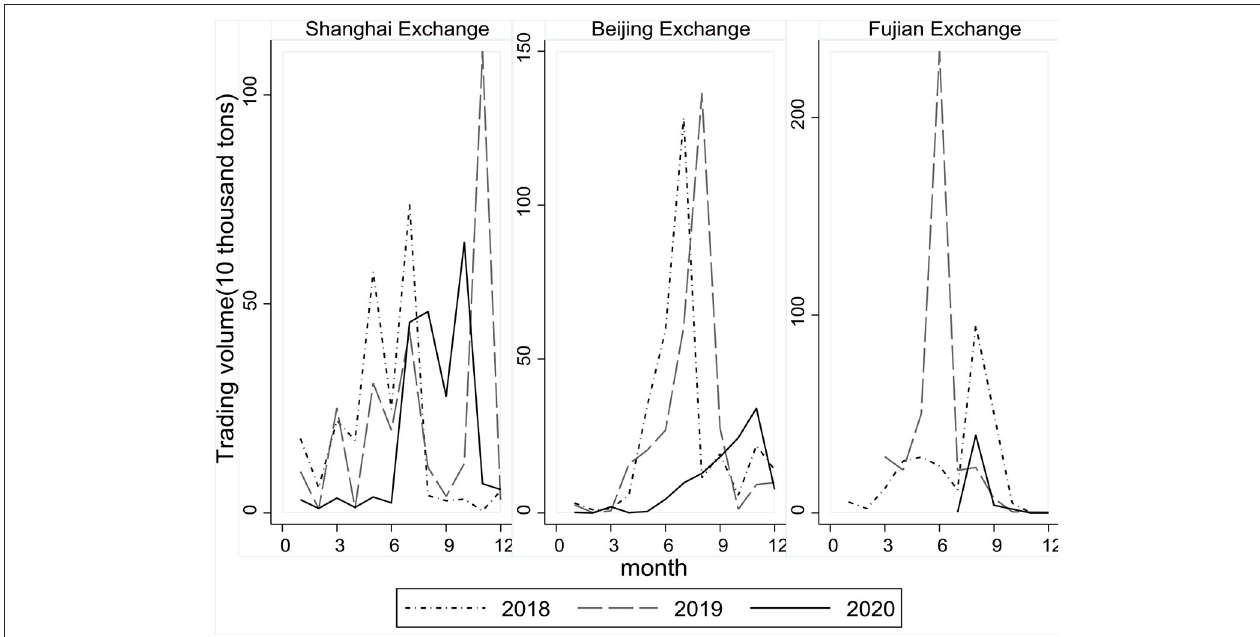
FIGURE 5 | Monthly trading volume and continuity in